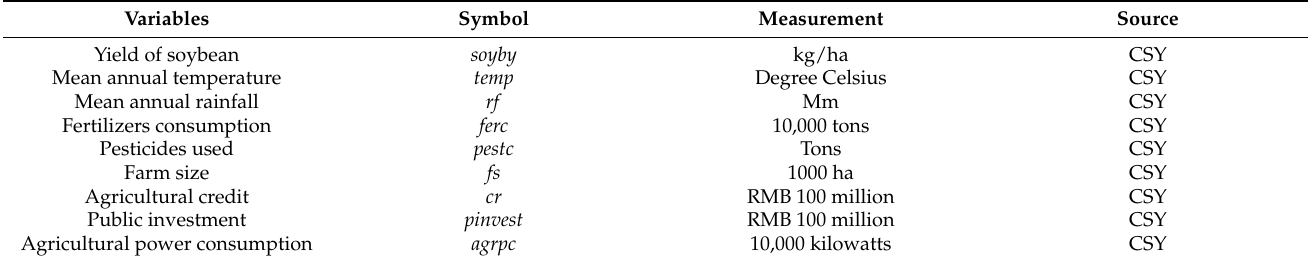
Table 1. The measurements of the studied variables and data source.